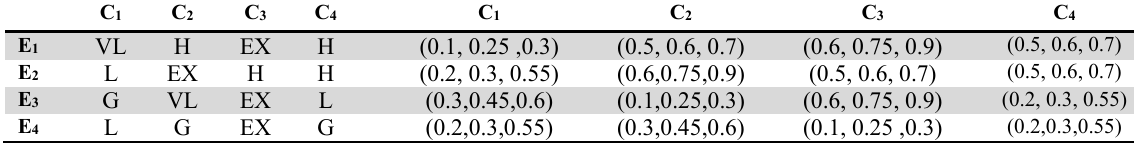
Aggregated decision matrix for fuzzy Shannon’s Entropy